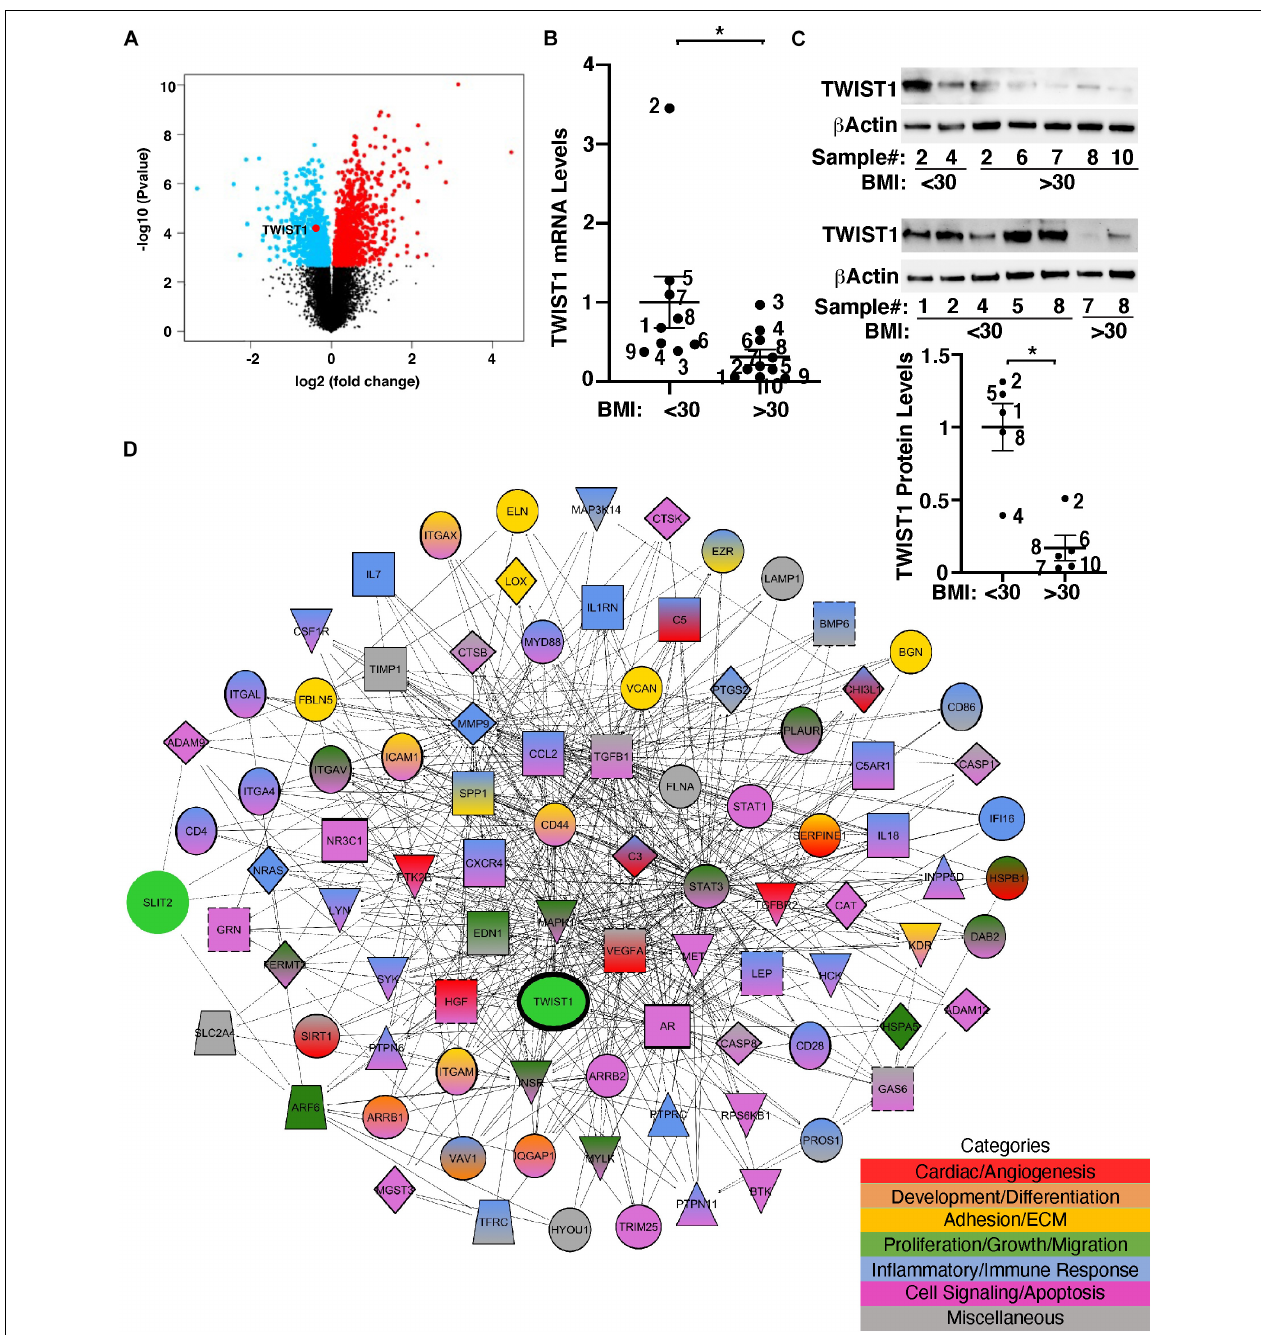
FIGURE 1 | TWIST1 expression in obese human subcutaneous adipose ECs is lower than lean ECs. (A) Volcano plot of differentially expressed genes, including TWIST1, in eight obese vs. seven lean adult human subcutaneous adipose samples from the GSE55200 dataset. Blue indicates significantly down-regulated genes and red indicates significantly up-regulated genes with Benjamini and Hochberg adjusted p -values < 0.05. (B) Graph showing the TWIST1 mRNA levels in ECs isolated from lean (BMI < 30) vs. obese (BMI > 30) human adipose tissues ( n = 9–10, mean ± SEM, * p < 0.05). The numbers along the dots correspond to the clone numbers in Table 1 . (C) Immunoblots showing the TWIST1 and β -Actin protein levels in ECs isolated from lean (BMI < 30) vs. obese (BMI > 30) human adipose tissues ( n = 5, mean ± SEM, * p < 0.05). The numbers along the dots correspond to the clone numbers in Table 1 . (D) Network showing connections among TWIST1, SLIT2, and genes from the top 30 BP GO Term categories derived from 1,302 significantly differentially expressed down and upregulated genes with Benjamini and Hochberg adjusted p -values < 0.05 from the GSE55200 dataset. Genes are color-coded by GO Term categories. Red, angiogenesis-related genes; Orange, development-related genes; Gold, ECM and cell adhesion-related genes; Dark green, cell proliferation, migration-related genes; Blue, inflammation and/or immune response-related genes; Purple, cell signaling and/or apoptosis-related genes; Gray, miscellaneous category-related genes; Black outlines, genes from the GSE55200